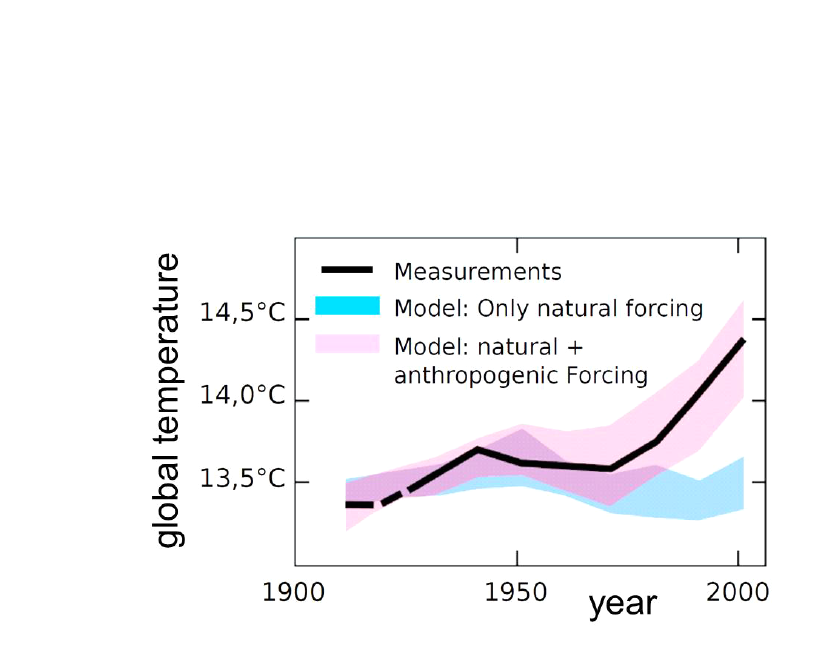
Fig. 5. – The evolution of the global temperature is plotted from 1900 to 2000 and compared with two model calculations —the blue one considering only natural forcing effects, the red one including the man-made contribution. The graph is a copy from the presentation by D.